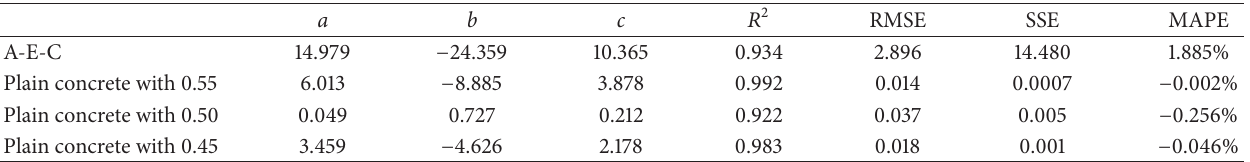
Table 8: Value of 𝑎, 𝑏,𝑐, 𝑅 2 , SSE, RM, and M